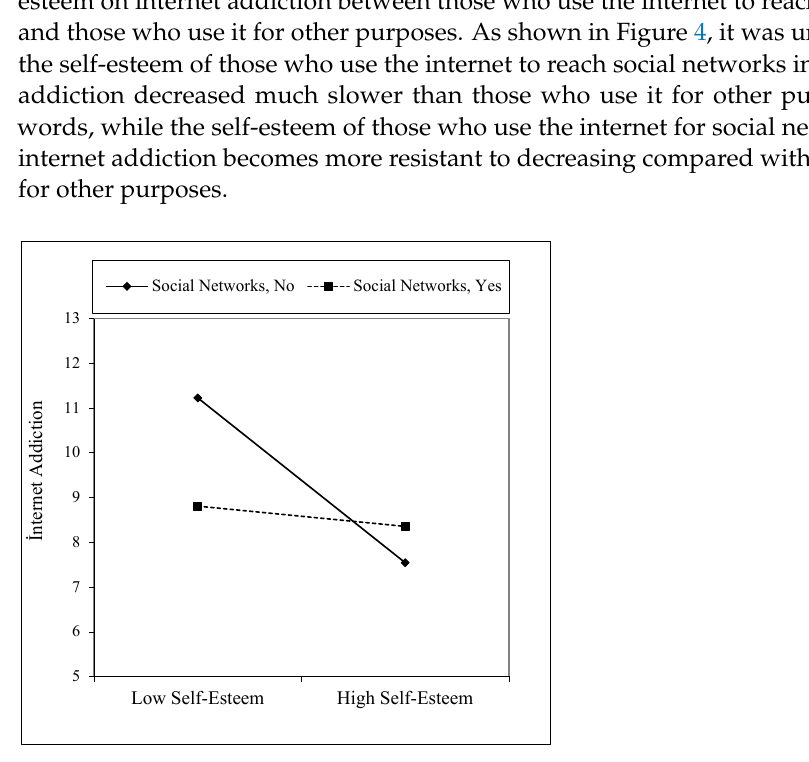
Figure 3. Interaction effect of self-esteem and location on internet addiction.